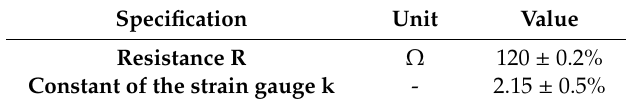
Figure 5. Foil strain gauges glued to the surface of the sample. Table 4. Technical specification of Tenmex TF-5-2x foil strain gauges [45].